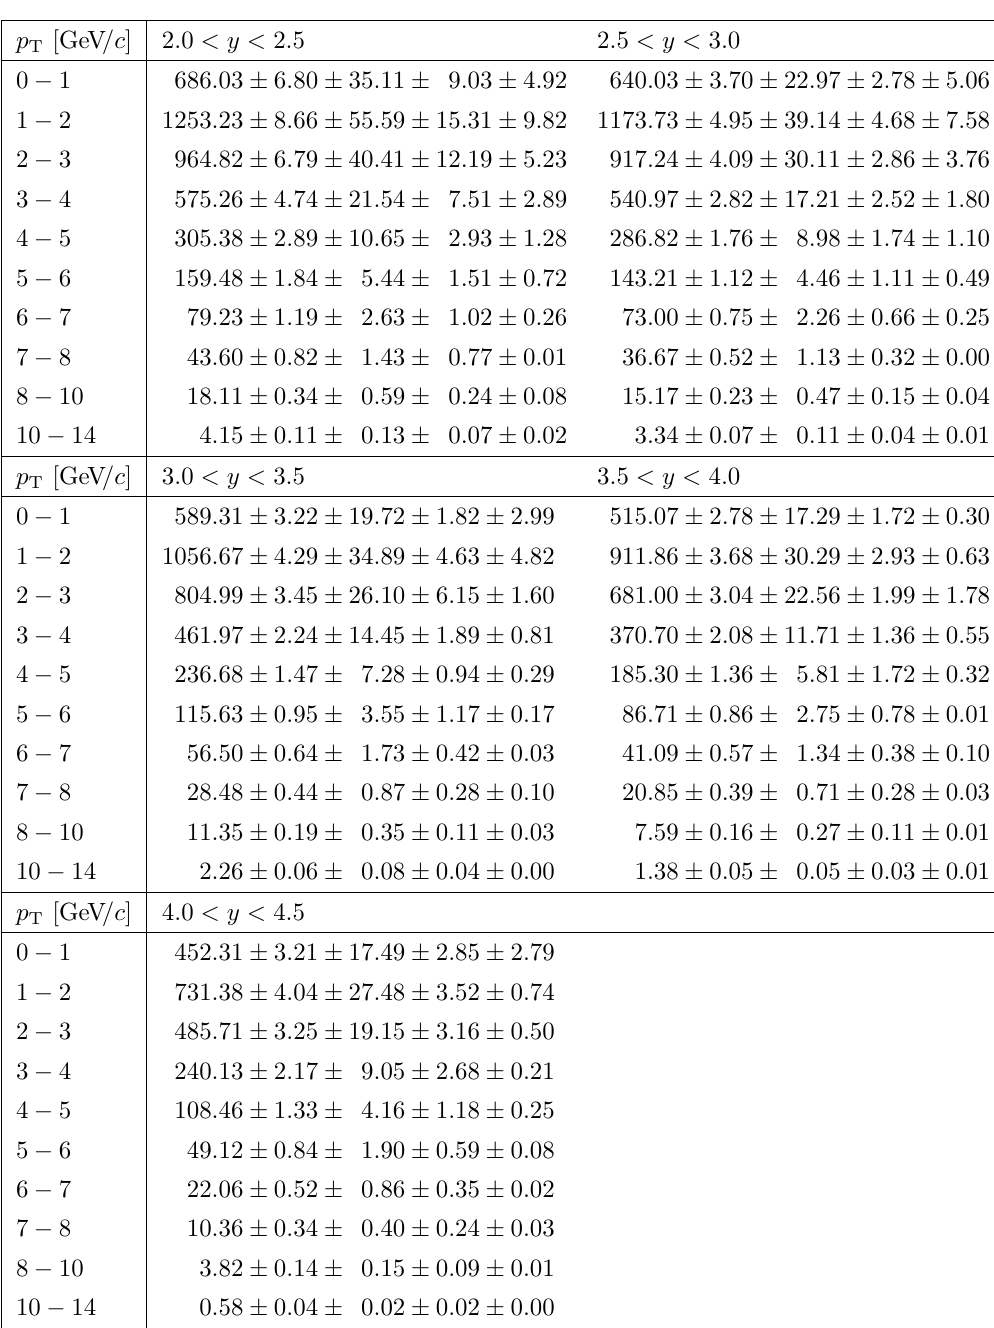
Table 2 . Double-differential production